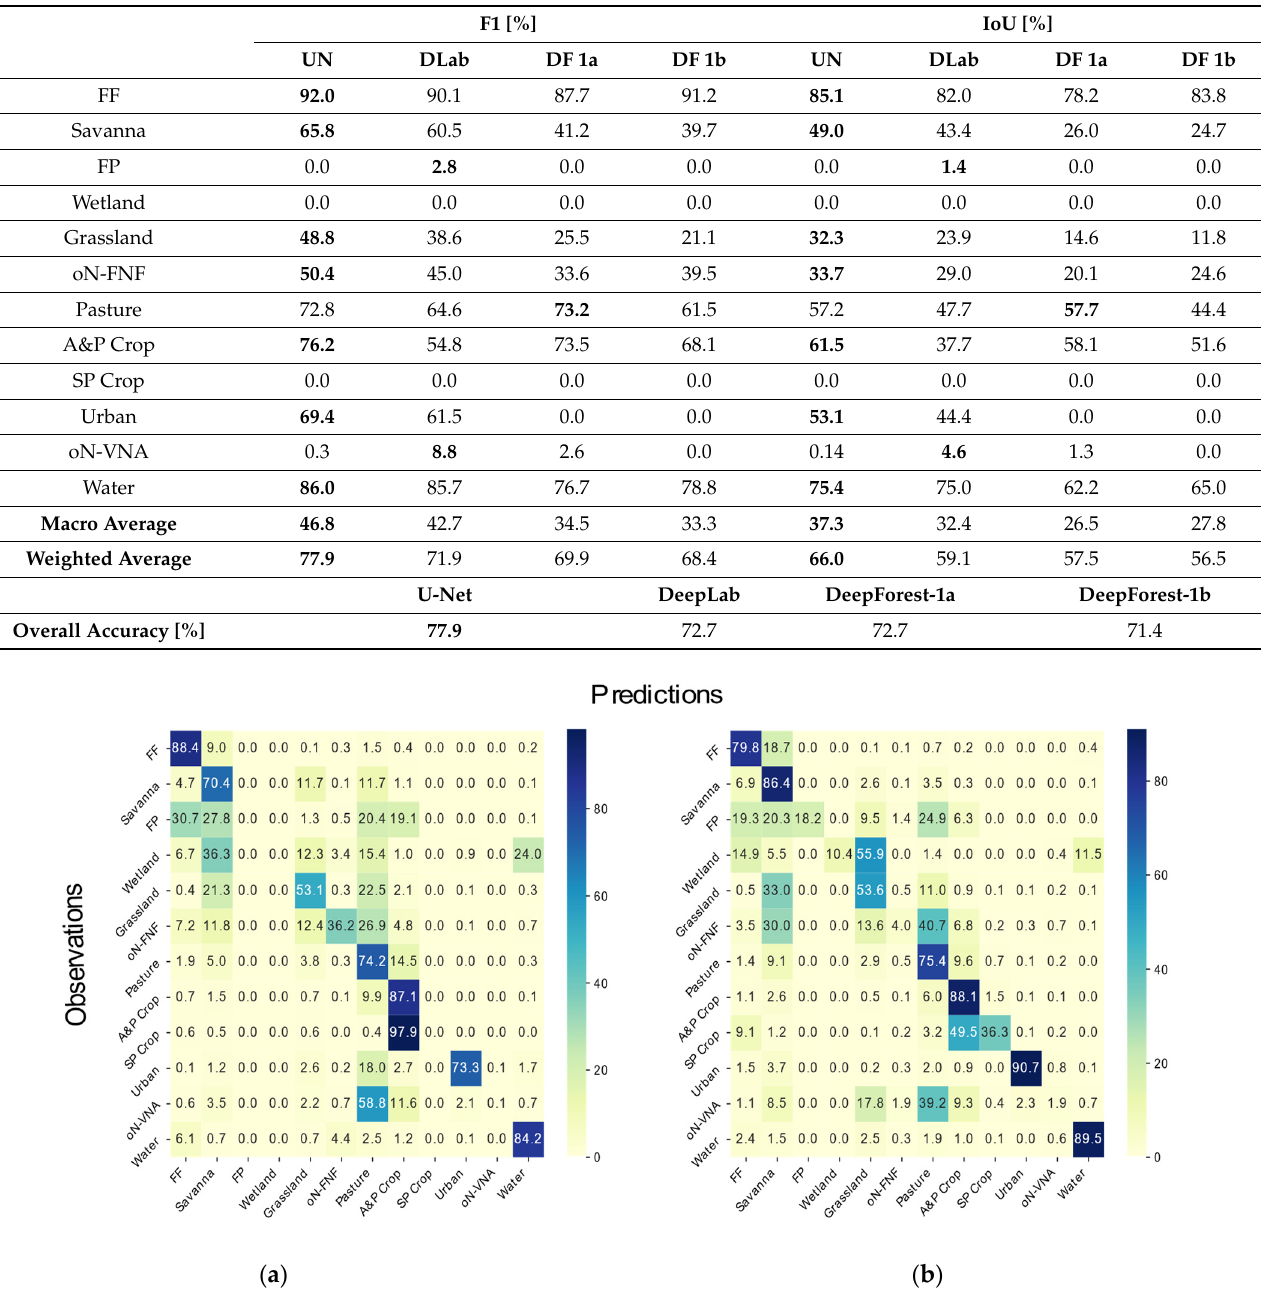
Figure 6. Confusion matrices for the best ‐ performing model with mono ‐ modal data (( a ): U ‐ Net) vs. multi ‐ modal data (( b ): DeepLab). Table 3. Test accuracies of the classifications based on multispectral data (S2 dataset) for SotA and